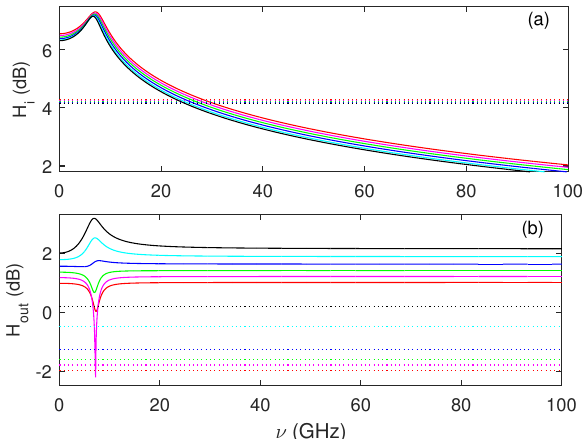
Figure 5. (color online) Same as Figure 4 but for the case of moderate coupling between EAM and VCSEL cavities ( d EAM = 0.5 µ m). ( a ) and ( b ) correspond to modulation of injection current, i.e., H i ( ν ) from Equation (21) and EAM losses α EAM , i.e., H out ( ν ) from Equation (18),